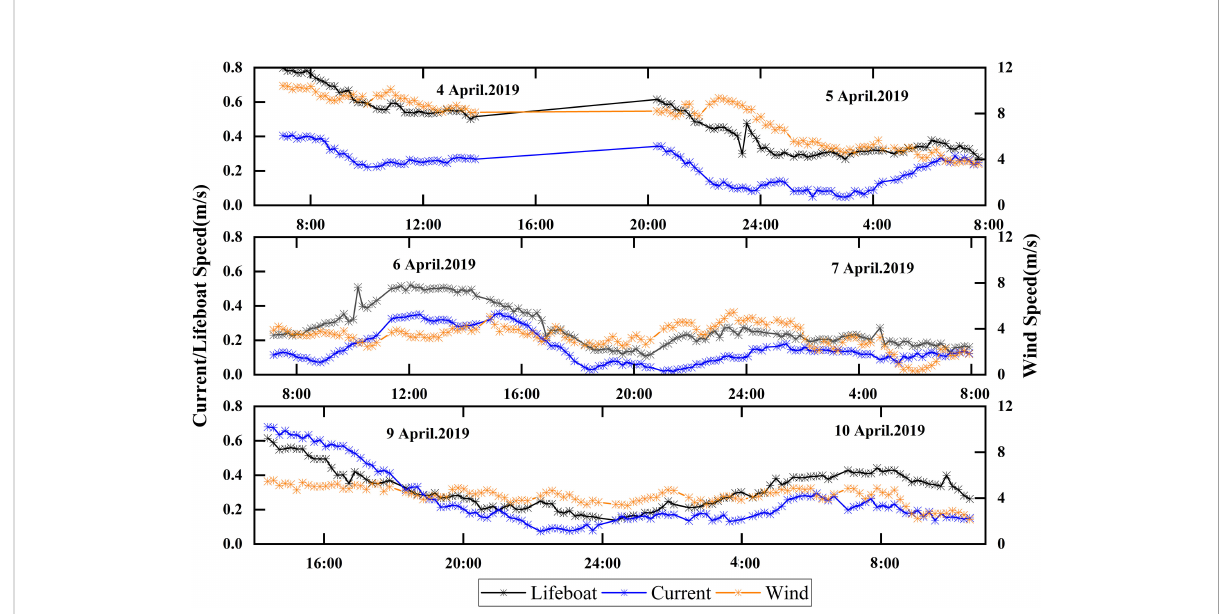
FIGURE 5 Values of drift speed, wind speed and current speed over time for the open lifeboat, with the black lines representing the open lifeboat, the blue lines representing the current, and the orange lines representing the wind.